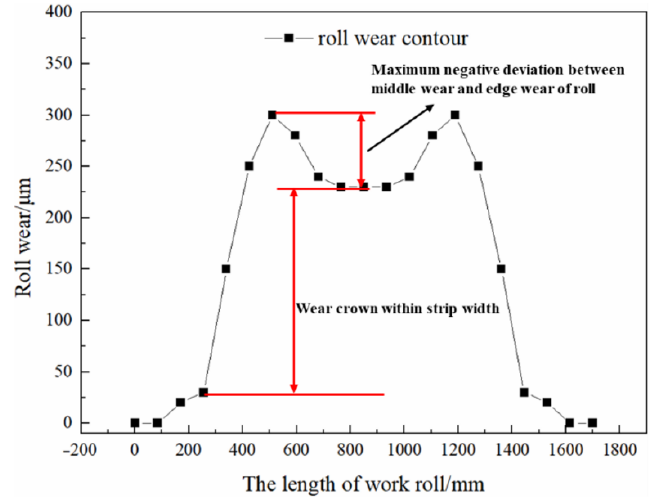
Figure 9. Characteristic value of wear roll contour.